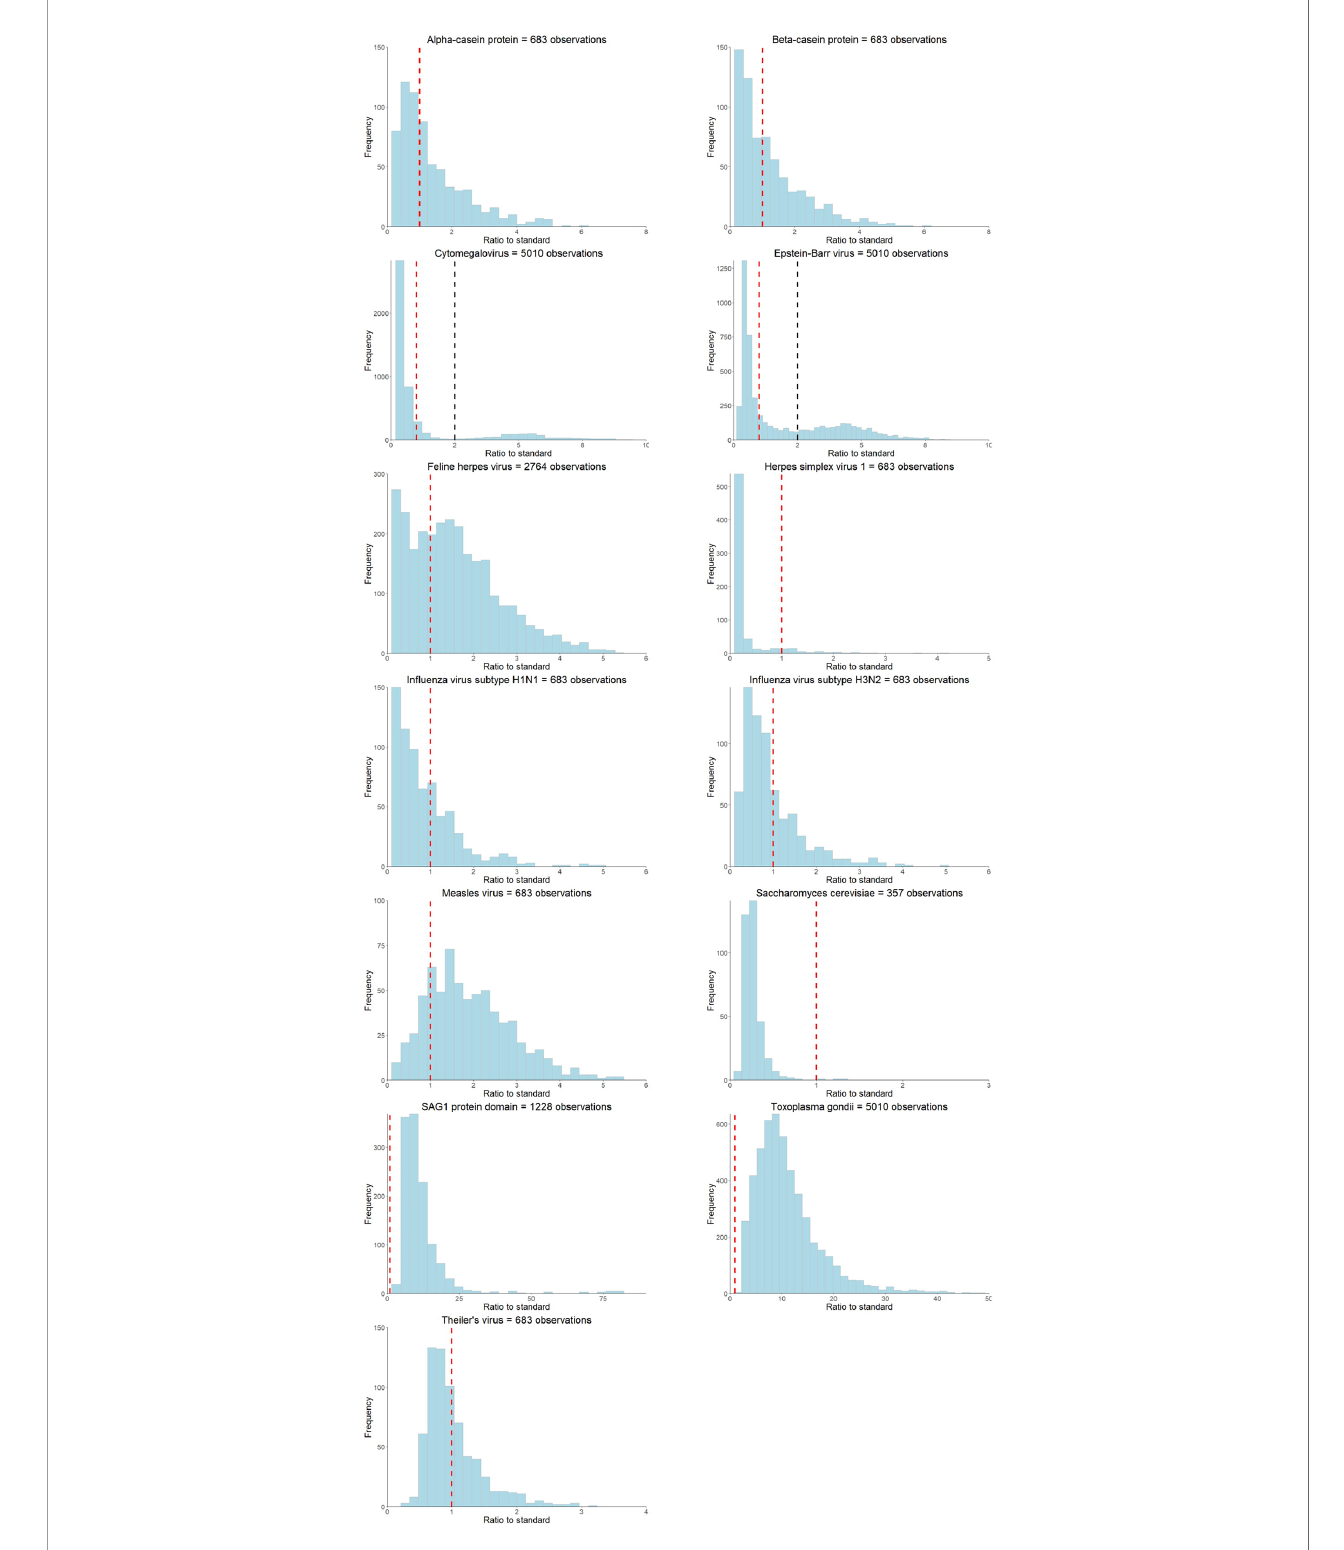
FIGURE 2 | Ratio to standard distributions of the antibodies measured at the ALSPAC seven-year clinic. The red dashed line represents the ratio to standard threshold of >=1 and the black dashed line represents the subjective threshold based on visually identifying the trough in distributions for bimodal